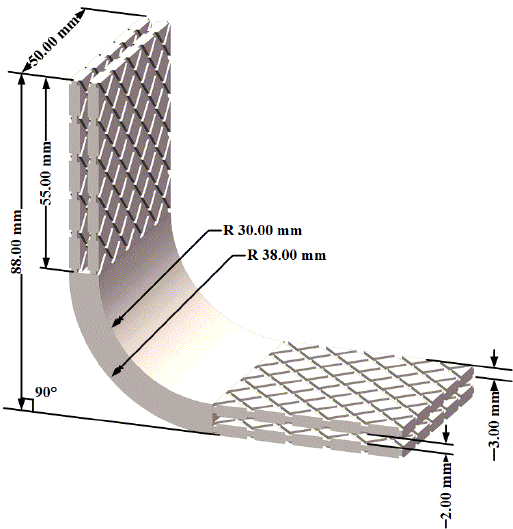
Figure 1. Schematic diagram of L-shaped metal component. The ± 45 ◦ groove structure was designed in the L-shaped metal component, as shown in Figure 2. The value of 45 ◦ was relative to the boundary of the groove structure. Both sides of the bonding component had groove structure, which can eliminate the warpage caused by the groove structure. The size of the groove was determined based on previous